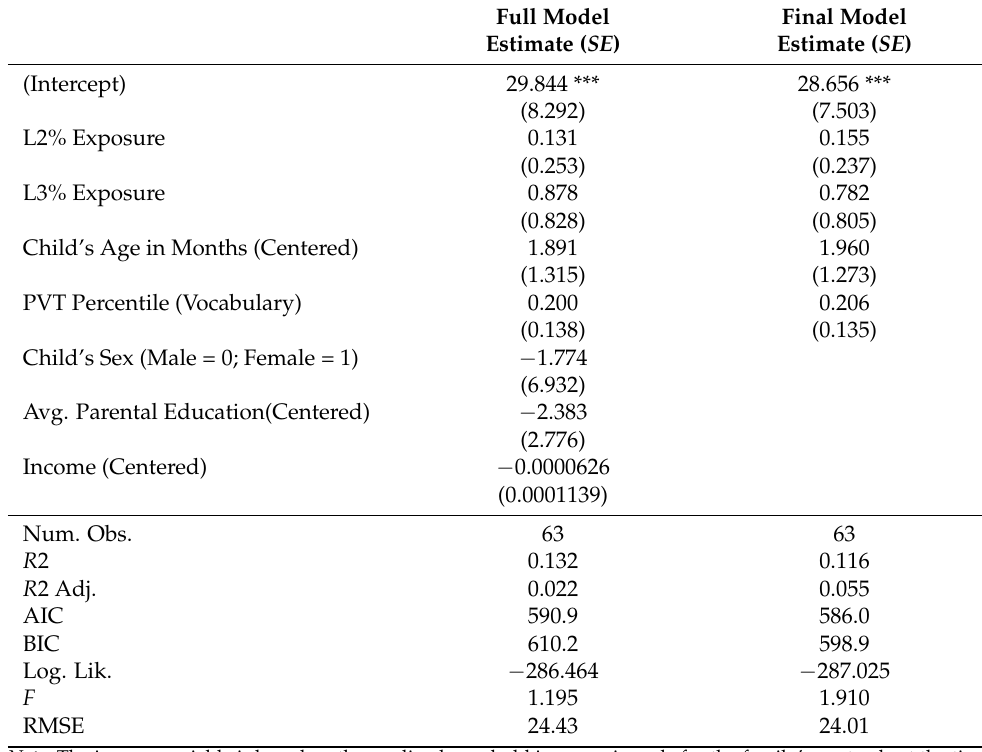
Table 5. Regression Models for Analysis Approach 1-L2%